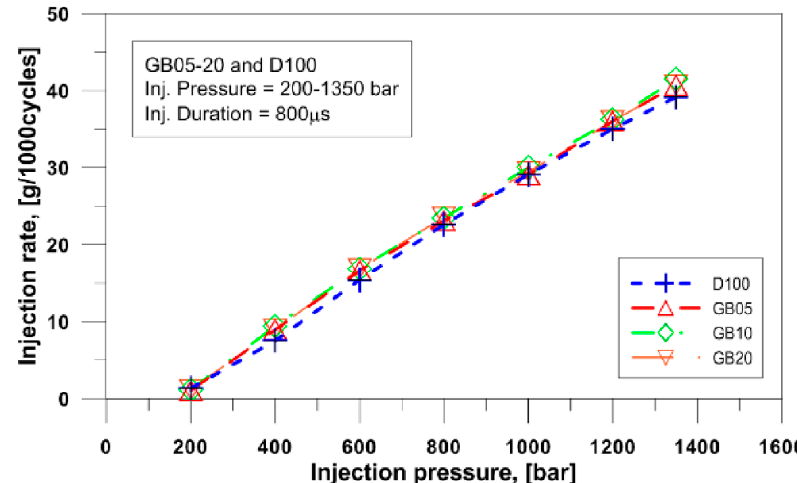
Figure 8. The effect of injection pressure on injection flow rate of a gasoline-biodiesel blend [Reprinted by permission from (the RightsLink Permissions Springer Nature Customer Service Centre GmbH): (Springer Nature) (Journal of Mechanical Science and Technology) [108], Copyright (2018)].